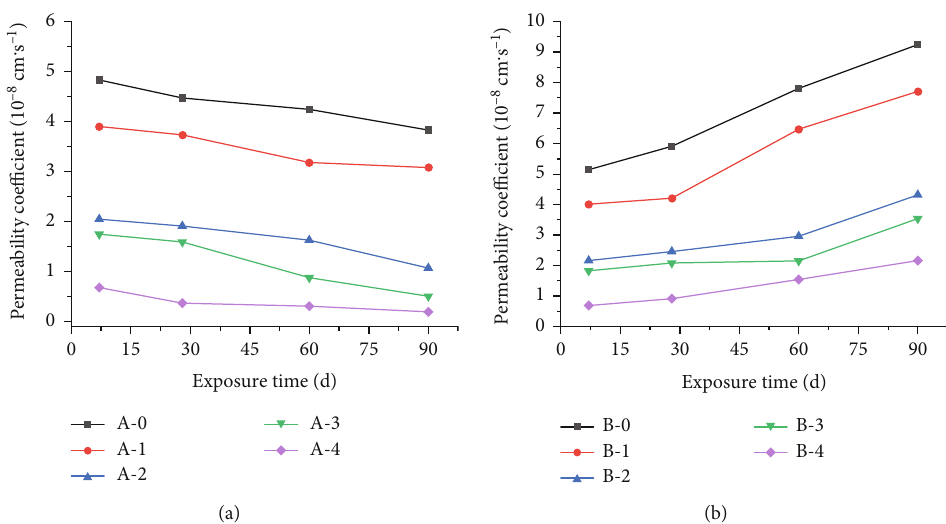
Figure 5: Permeability coe ffi cient of soil-cement: (a) permeability coe ffi cient of soil-cement in clear water; (b) permeability coe ffi cient of soil-cement in marine